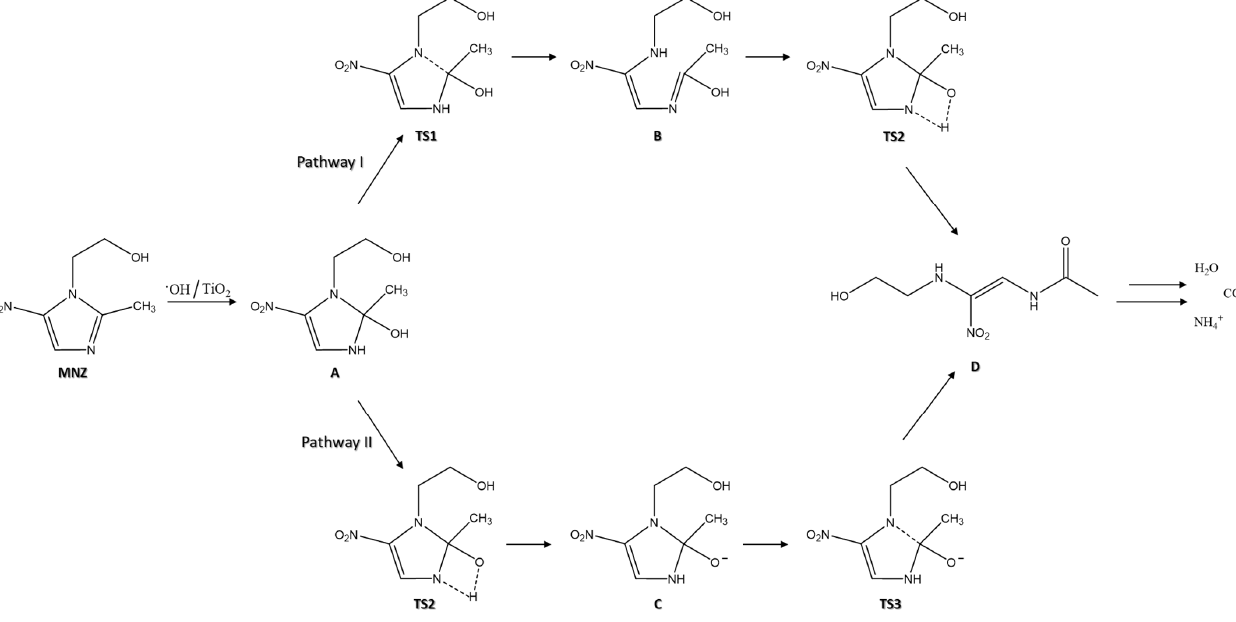
Figure 9. Schematic representation of two possible paths for the opening of the imidazole ring in the degradation mechanism of MNZ (adapted from [78]).